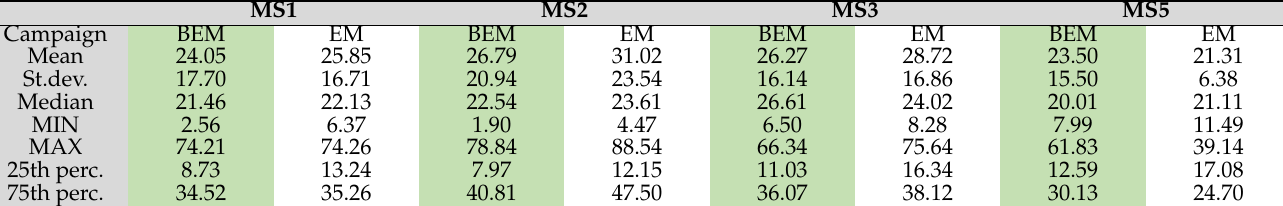
Table 3. Descriptive statistics for data collected via low-cost sensors, at 4 different locations in Novi Sad.